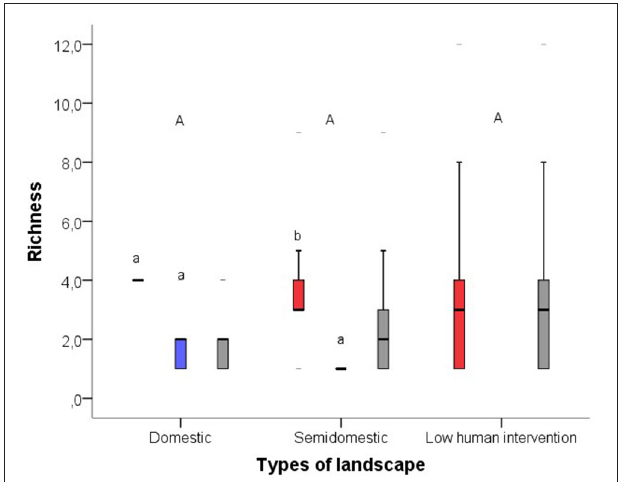
FIGURE 4 | Total and partial average use consensus (UC), according to biogeographic origin of the firewood species in the different categories of landscape (domestic, semi-domestic and low human intervention): Key: (cid:4) UC of native plants; (cid:4) UC of exotic plants; (cid:4) Total UC. A: No significant differences to use consensus between different categories of landscape ( p > 0.05). a: No significant differences to use consensus according to biogeographic origin of the firewood species in each different categories of landscape ( p >